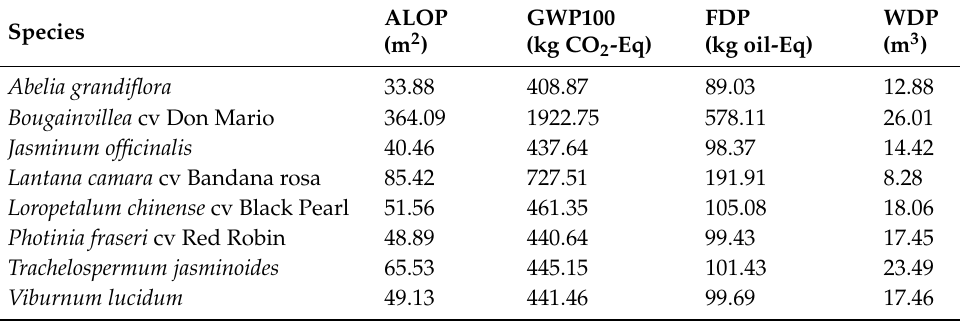
Table 8. Environmental implications associated with novel and sustainable production model (NSM) among 8 selected ornamental species of 1000